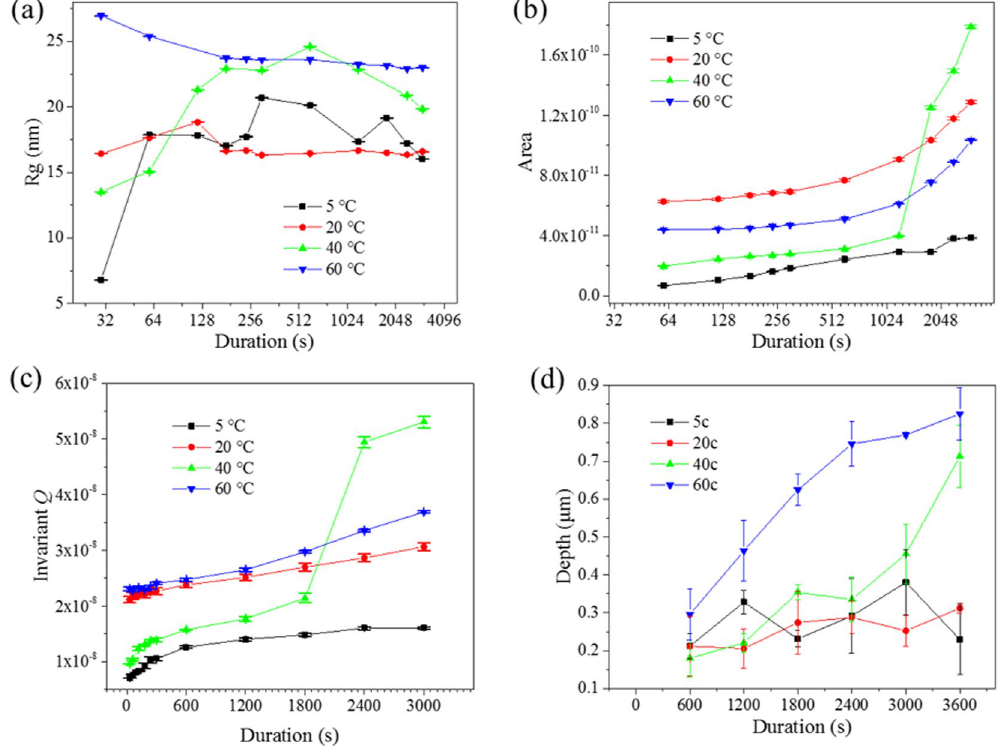
Figure 5. ( a ) The radius of gyration R g at different solution temperatures plotted against the process duration. X axis (duration) was plotted with Logarithm binary. ( b ) The surface area A calculated through Porod’s law. ( c ) The Porod invariant Q at different temperatures plotted against the process duration. ( d ) The penetration depth of dealloyed region, measured on cross-section view of ex-situ dealloyed samples. The value of A (40 °C) suddenly doubled at 1800 s. At the end of the in-situ tests (3000 s), the sample dealloyed at 40 °C offered the largest surface area, followed by the 20 °C dealloyed samples and the 60 °C dealloyed samples. The surface area of 5 °C dealloyed sample was always the smallest among the 4 series.